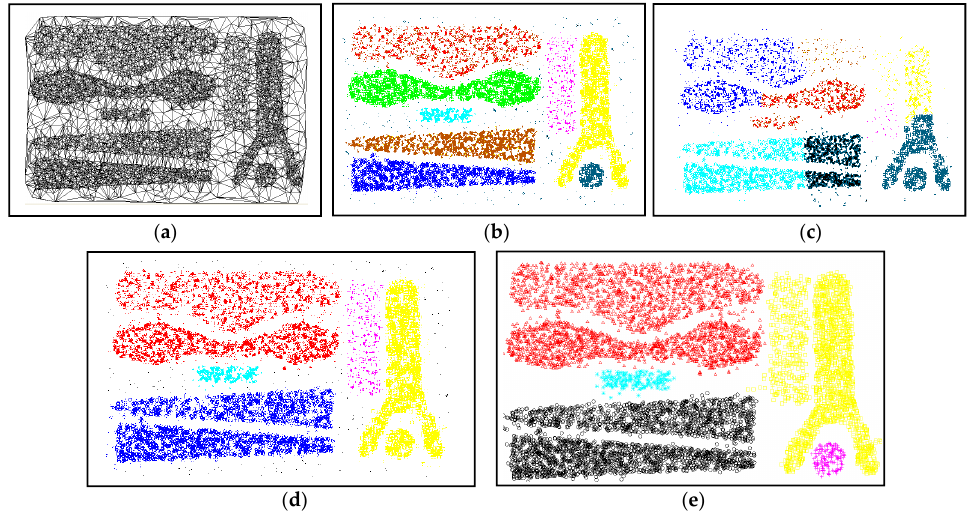
Figure 11. Testing data set D1 of ASC: ( a ) Graph built by triangulation of D1; ( b ) clustering result by ASC; ( c ) clustering result by DBSCAN; ( d ) clustering result by CURE; and ( e ) clustering result by